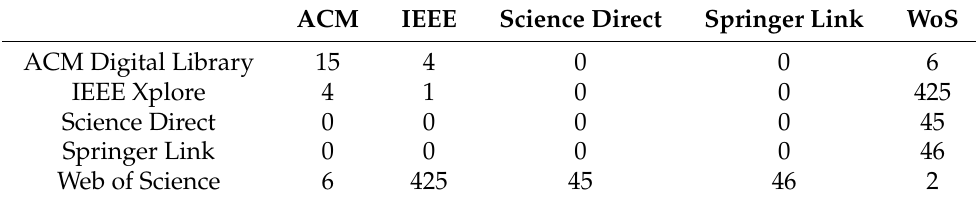
Table 2. Number of duplicates excluded, shown by each database